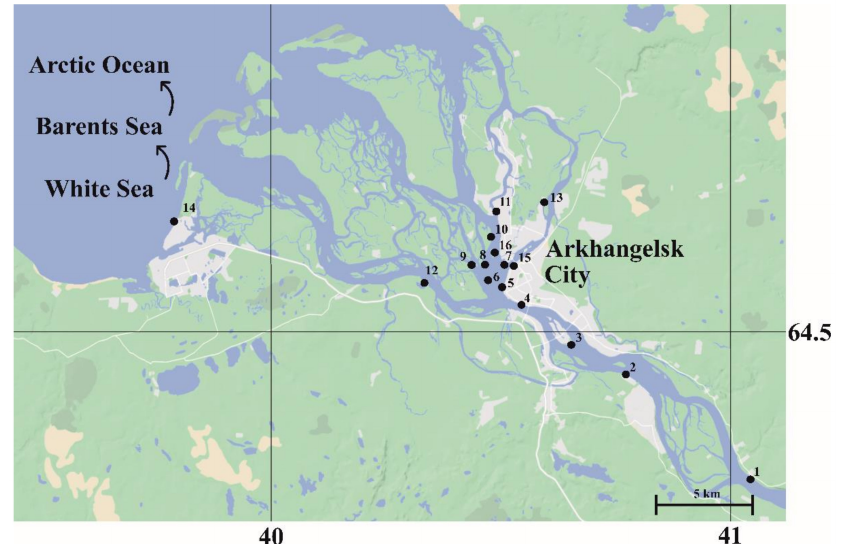
Figure 1. Sampling points in the Northern Dvina